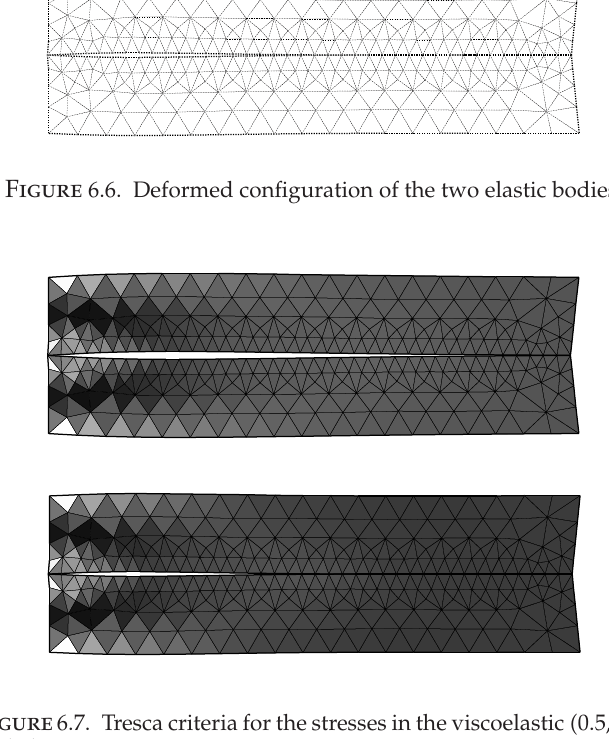
Figure 6.7 . Tresca criteria for the stresses in the viscoelastic ( 0 . 5 , 0 . 3 ) and elastic